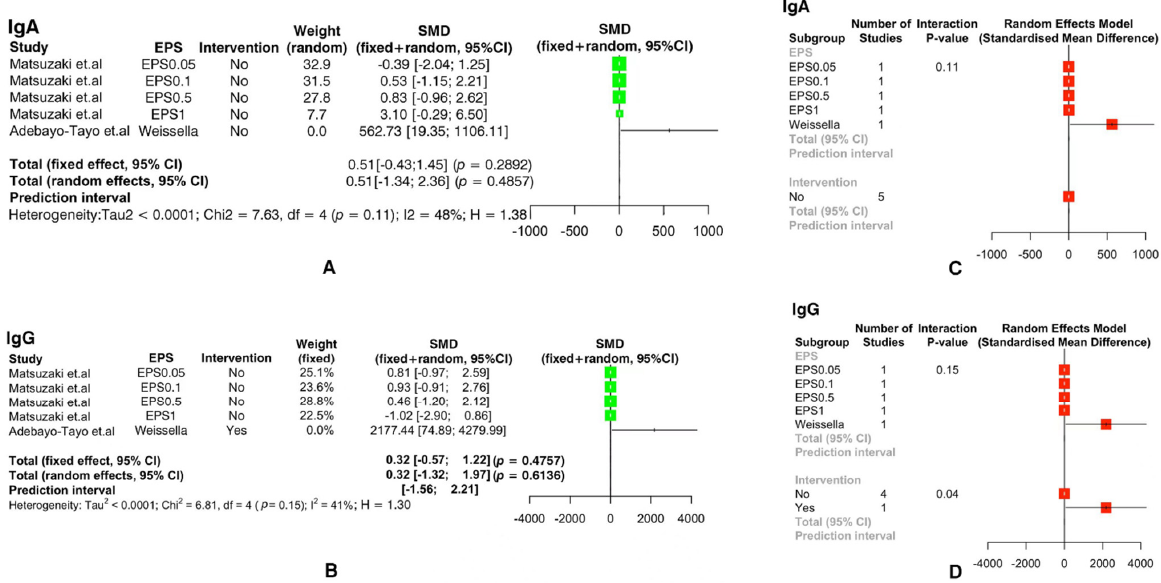
Figure 5 ． The forest plot illustrates the effects of extra-cellular polysaccharides on the immunity index of animals: ( A ) IgA, ( B ) IgG. Based on the above figure, a forest plot of the effect of using interfering media before EPS treatment and the effect of different concentrations of EPSs on immunity index was made: ( C ) IgA, ( D ) IgG. (Positive and negative values indicate increases or decreases in the production of immune factors. SMD: standardized mean difference.)